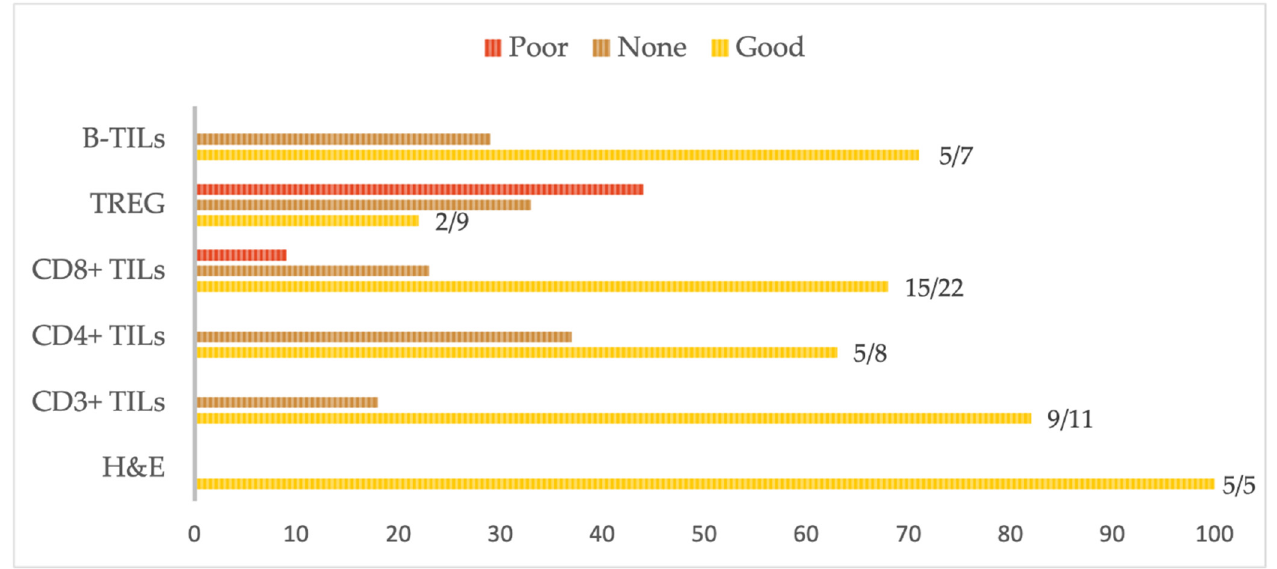
Figure 3. Synthesis of the effects of TILs on prognosis in EOC. This figure summarizes the conclusion of the articles exploring the effects of TILs on EOC prognosis, either being evaluated in HES or via the study of a surface marker. B-TILs are mostly identified using CD20. H&E: hematoxylin and eosin, and B ‐ TILs: B tumor ‐ infiltrating lymphocytes.